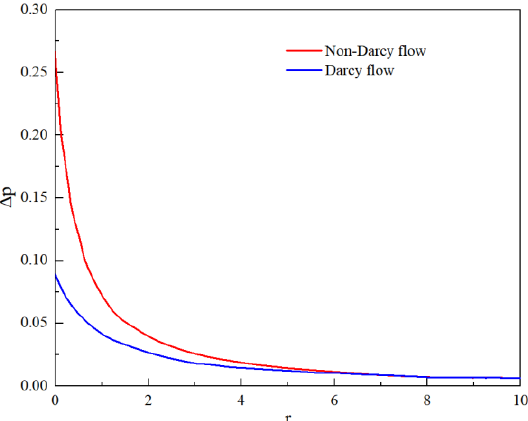
Figure 11. The comparison of pore pressure gradient of non-Darcy flow and Darcy flow.